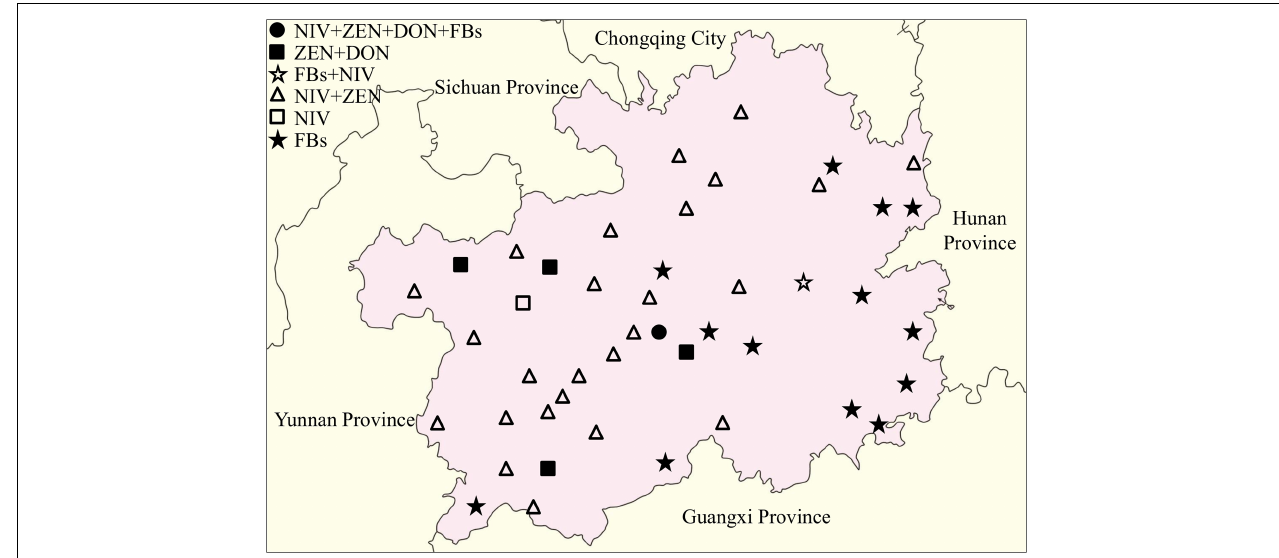
FIGURE 6 | Distribution of toxigenic genotypes of Fusarium isolates in the Guizhou Province of China.